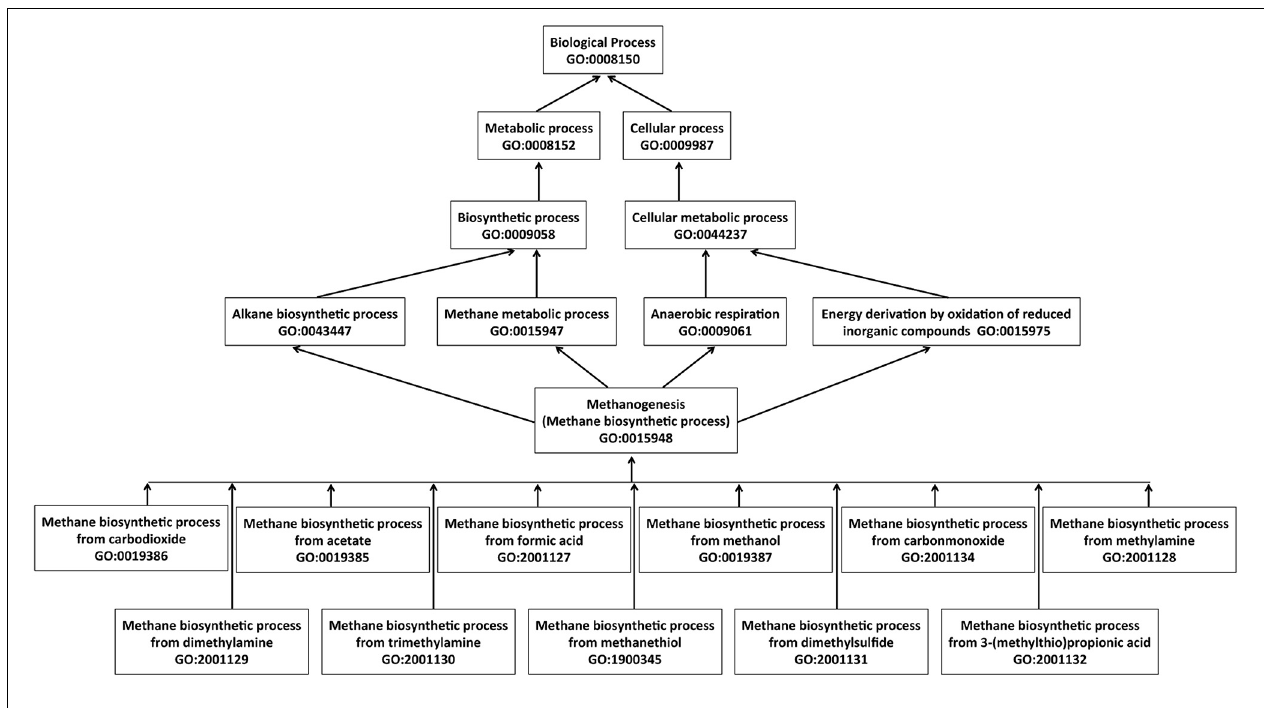
FIGURE 6 | Simplified graphical view of hierarchical terms for methane biosynthetic process in the Gene Ontology. The arrows represent “is_a” relationship, where an arrow begins at a